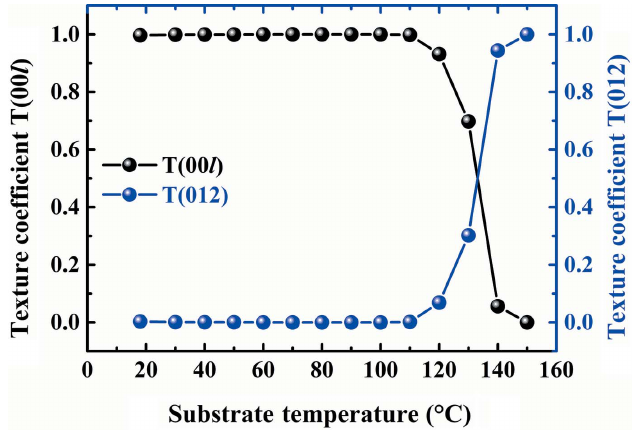
Figure 2 Texture coefficient variation of T (00 l ) and T (012) at substrate temperatures estimated from (cid:4) –2 (cid:4) scans (the growth rate is 1.61 A˚ min (cid:5) 1 and the deposition time is 240 min).